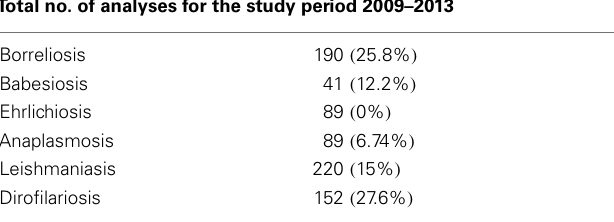
Table 2 |Total number of analyses and positive findings for the study period 2009–2013